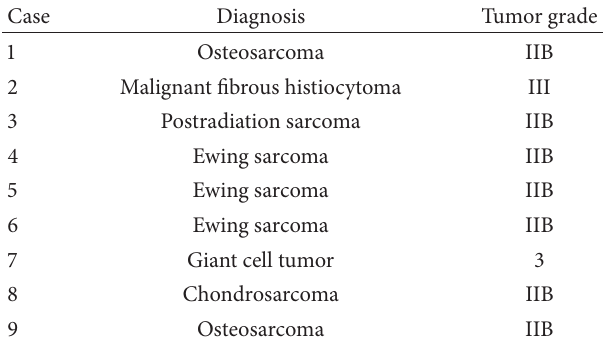
Table 1: Diagnosis and tumor